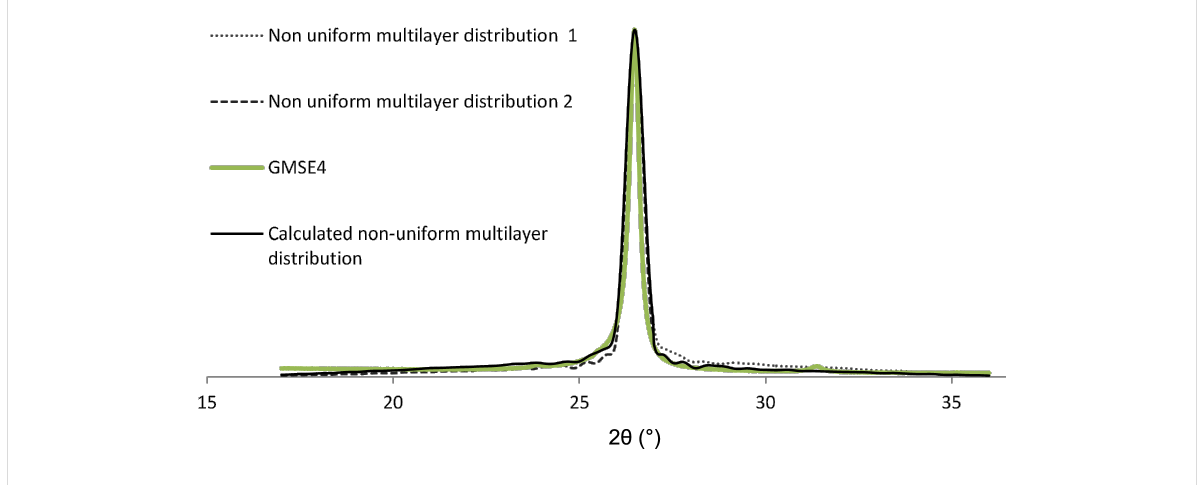
Figure 9: Nonuniform multilayer distribution curve for sample GMSE4 calculated from Equation 3.